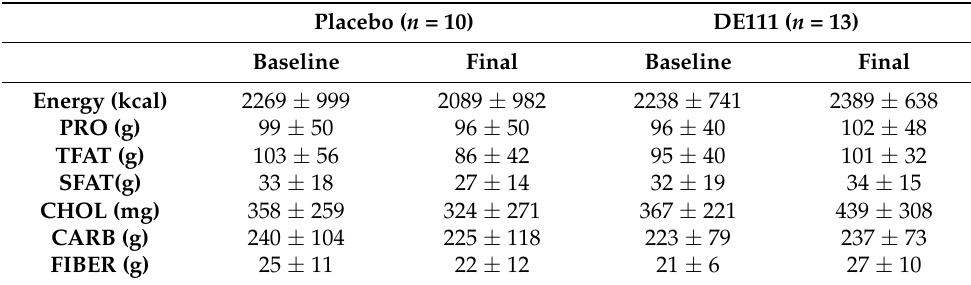
Table 2. Self-Reported Diet Intake Based on Two 24-Hour